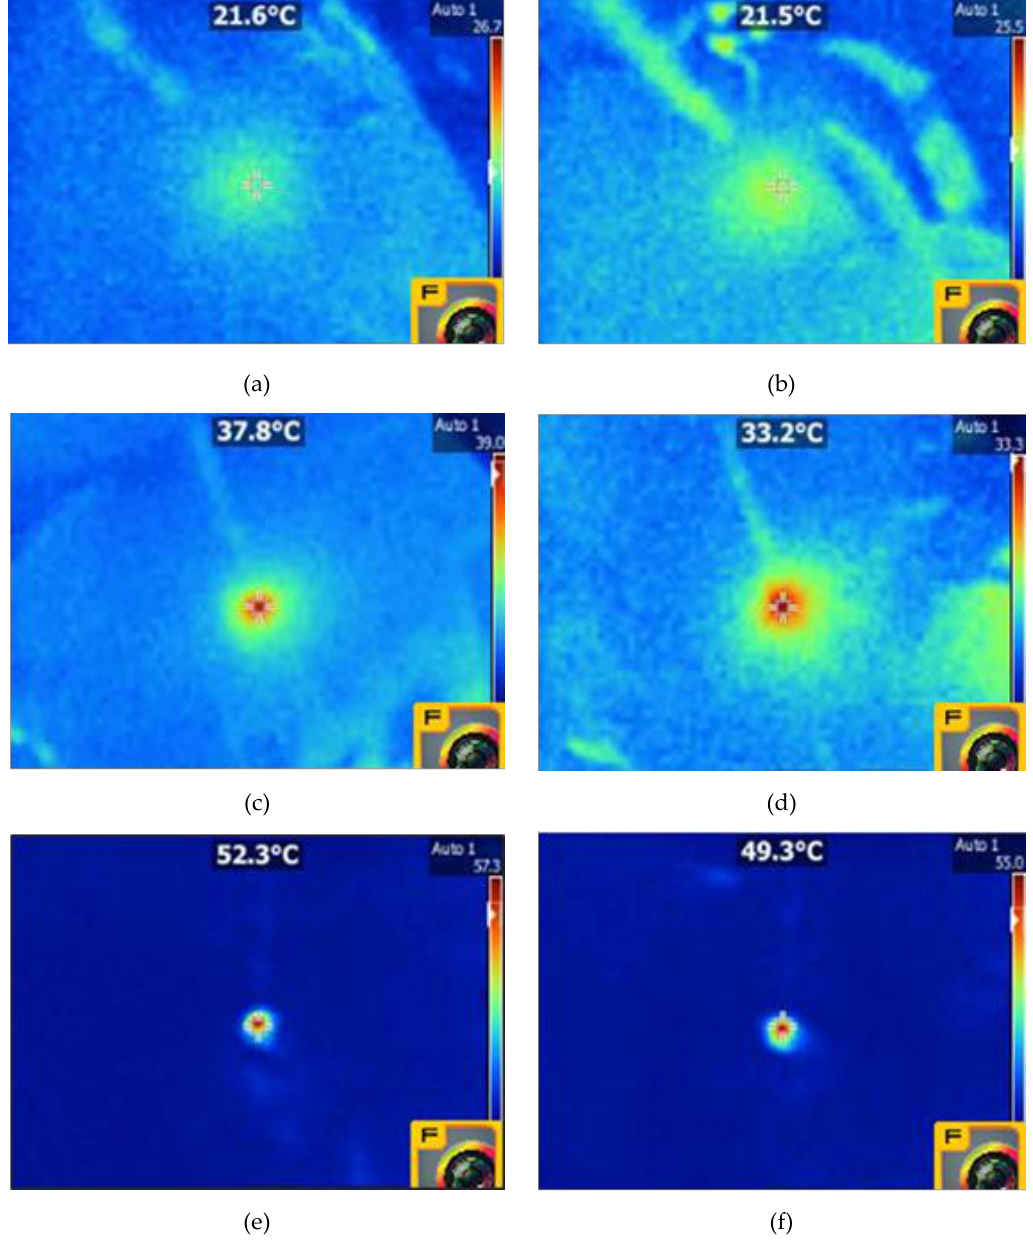
Figure 8. Infrared thermography of EM3 with random and aligned fibers and EM4 with 0.5% and 1% TrGO registered at 10 V and 2 cm: ( a ) EM3 with random fibers, ( b ) EM3 with aligned fibers, ( c ) EM4 with random fibers (0.5% TrGO), ( d ) EM4 with aligned fibers (0.5% TrGO), ( e ) EM4 with random fibers orientation (1% TrGO), and ( f ) EM4 with aligned fibers (1% TrGO).